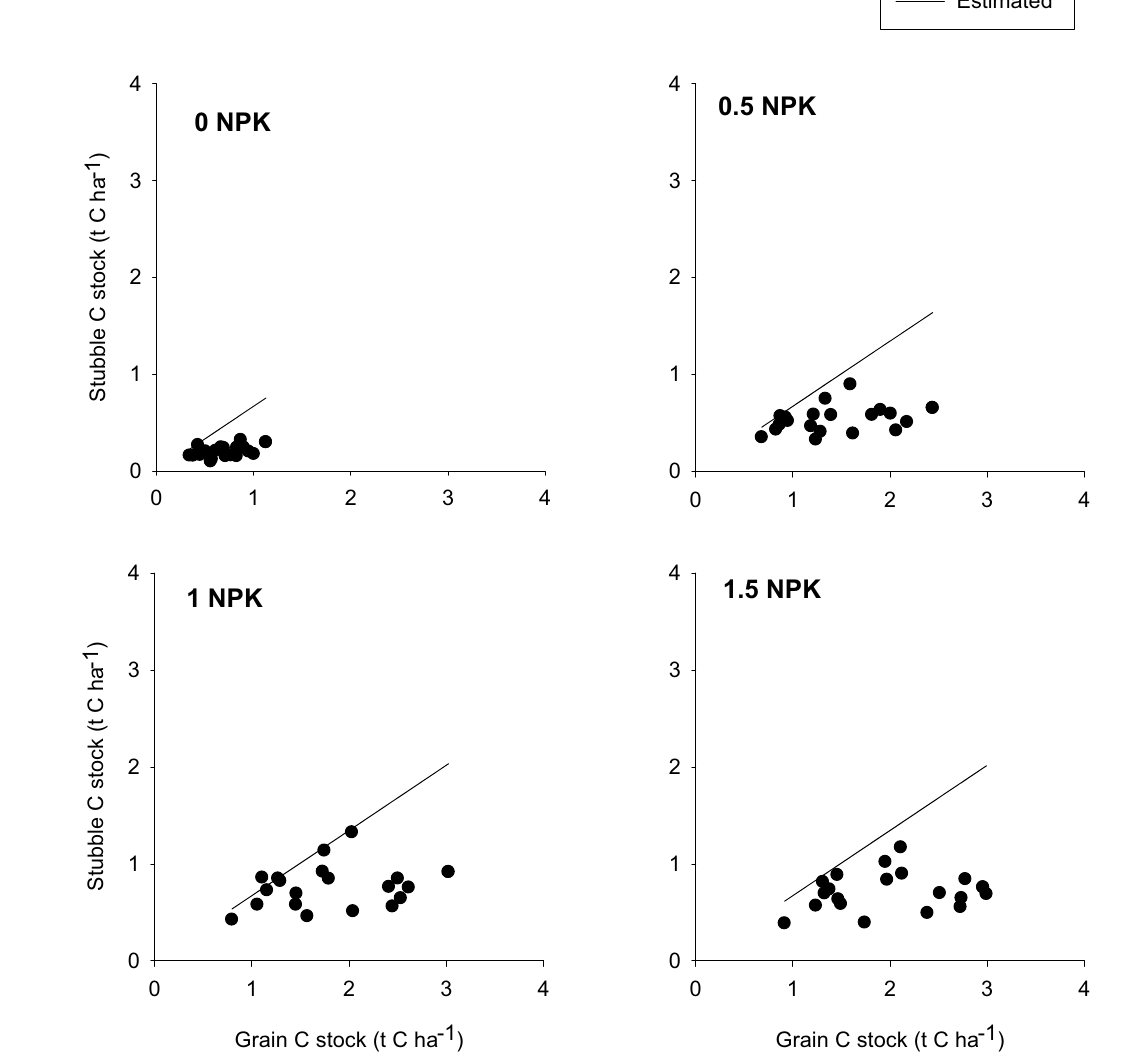
Figure 2. The relationship between grain C stock measured during 1932–2020 and stubble C stock based on measurements in 2020 (circles; see Table 2). Stubble C stock calculated with standard allometric functions for period 1932–2020 (solid